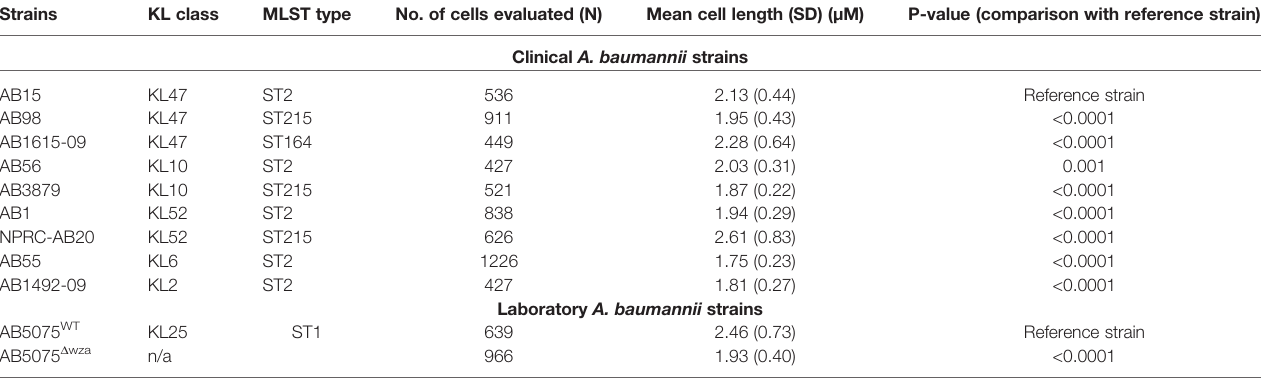
TABLE 1 | A. baumannii clinical strains isolated from patients across either the Siriraj or Songklanagarind hospitals in Thailand [partially reproduced from Kamuyu et al, (36)]. Strains KL class MLST type No. of cells evaluated (N) Mean cell length (SD) (µM) P-value (comparison with reference strain)